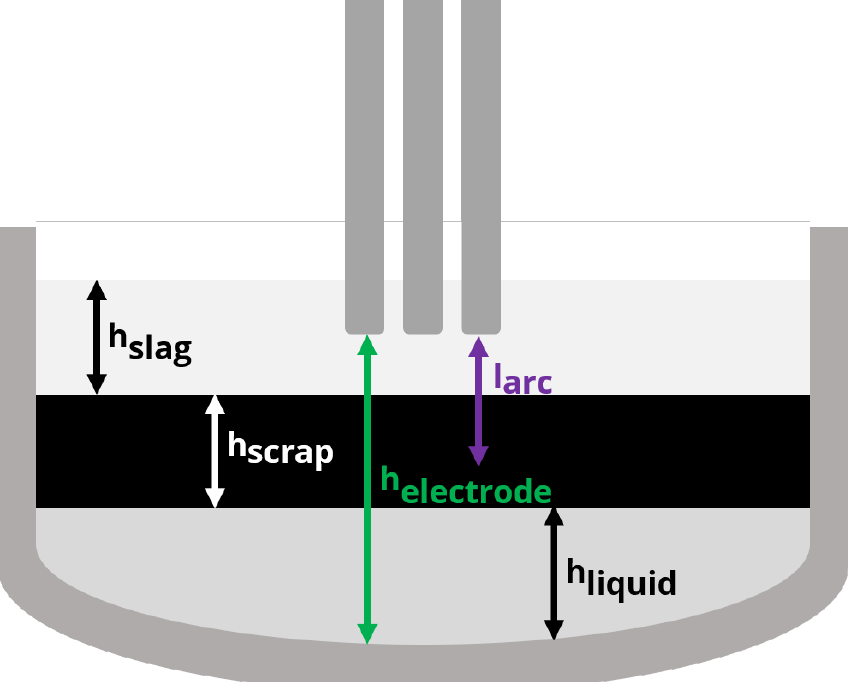
Figure 3. Variable and static dimensions used to calculate arc visibility for the arc efficiency